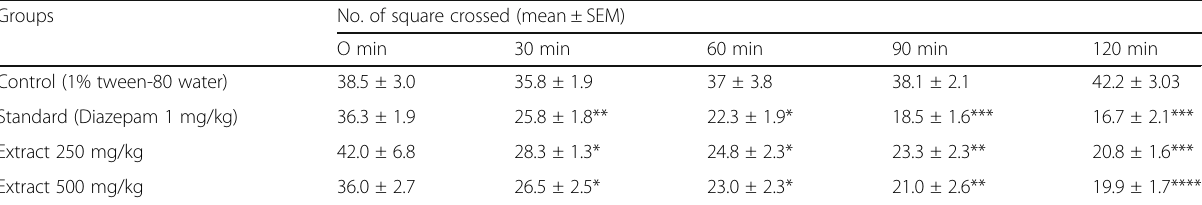
Table 3 Neuropharmacological effect of Lepisanthes rubiginosa L. on mice in Open Field method